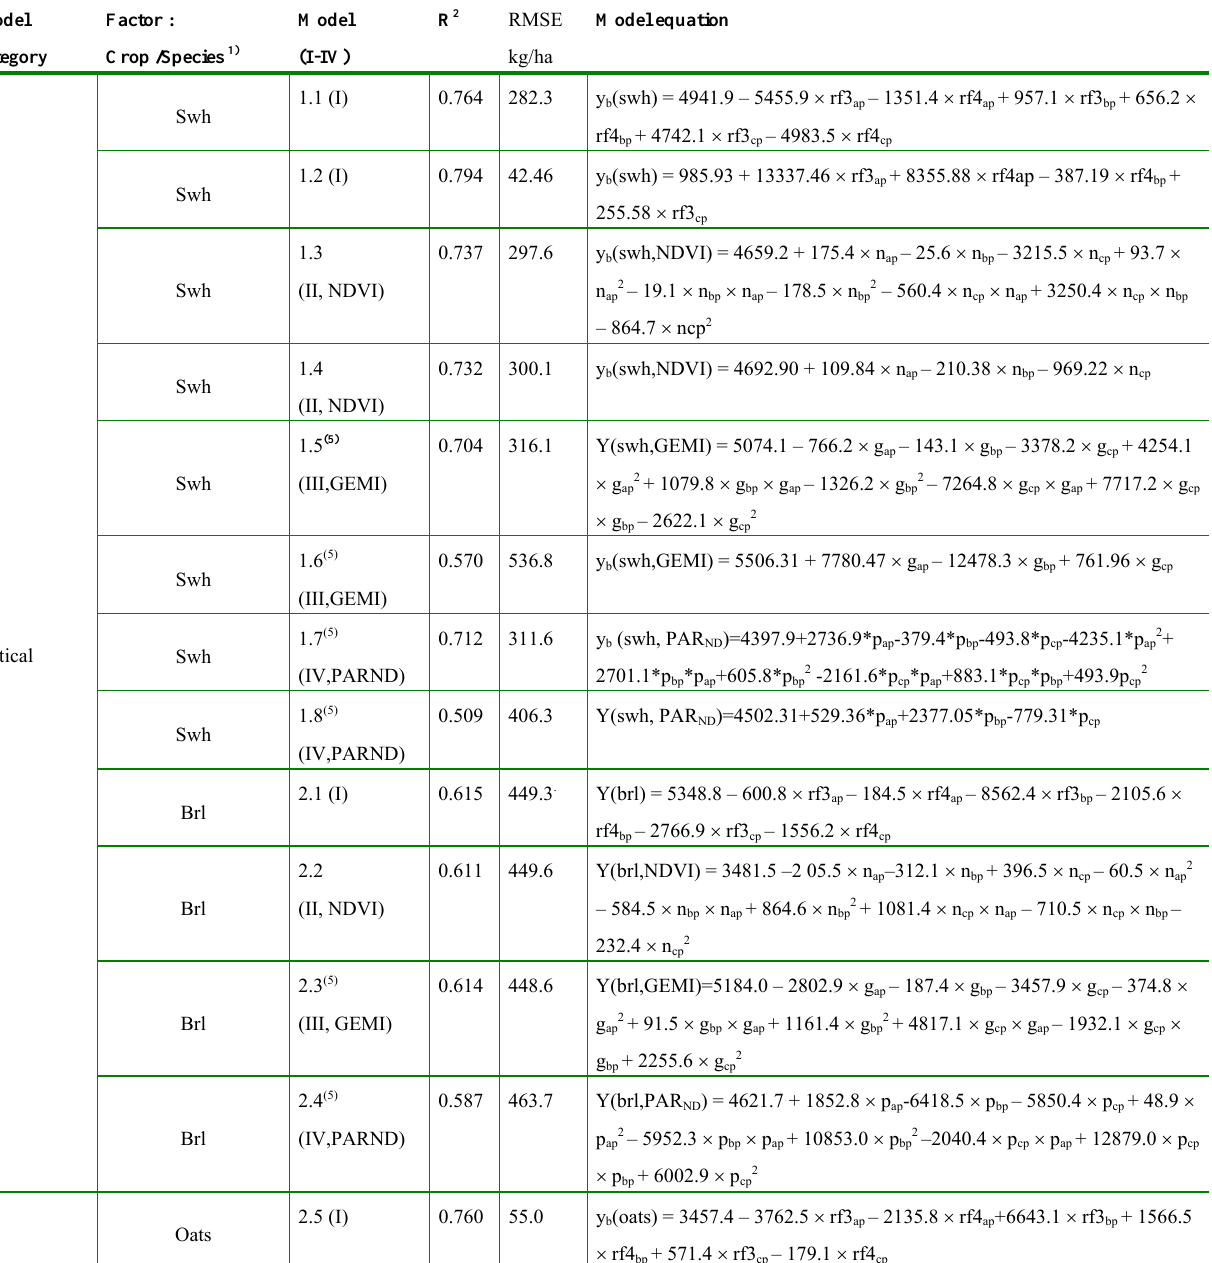
Table 12. SAR and optical VGI (I-IV) linear (REG/Stepwise) and non-linear (RSREG) yield models for spring cereals (1),(2)